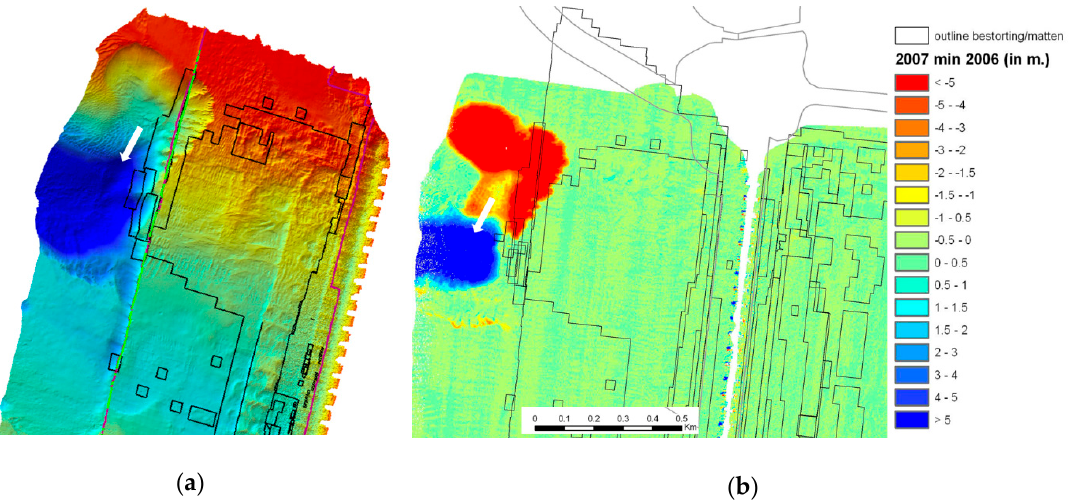
Figure 3. ( a ) Large subaqueous flow slide near Eastern Scheldt Storm Surge Barrier, Netherlands (Roompot channel (in 3D bathymetry), 2007; ( b ) Differential bathymetry 2007-2006 with scale and color scheme. Red = erosion (< ‒ 5 m), blue = deposition (> +5 m). Distance 500 m. Black lines indicate contours of bed protection, white arrows indicate flow slide direction. From Deltares, 2008 [8].